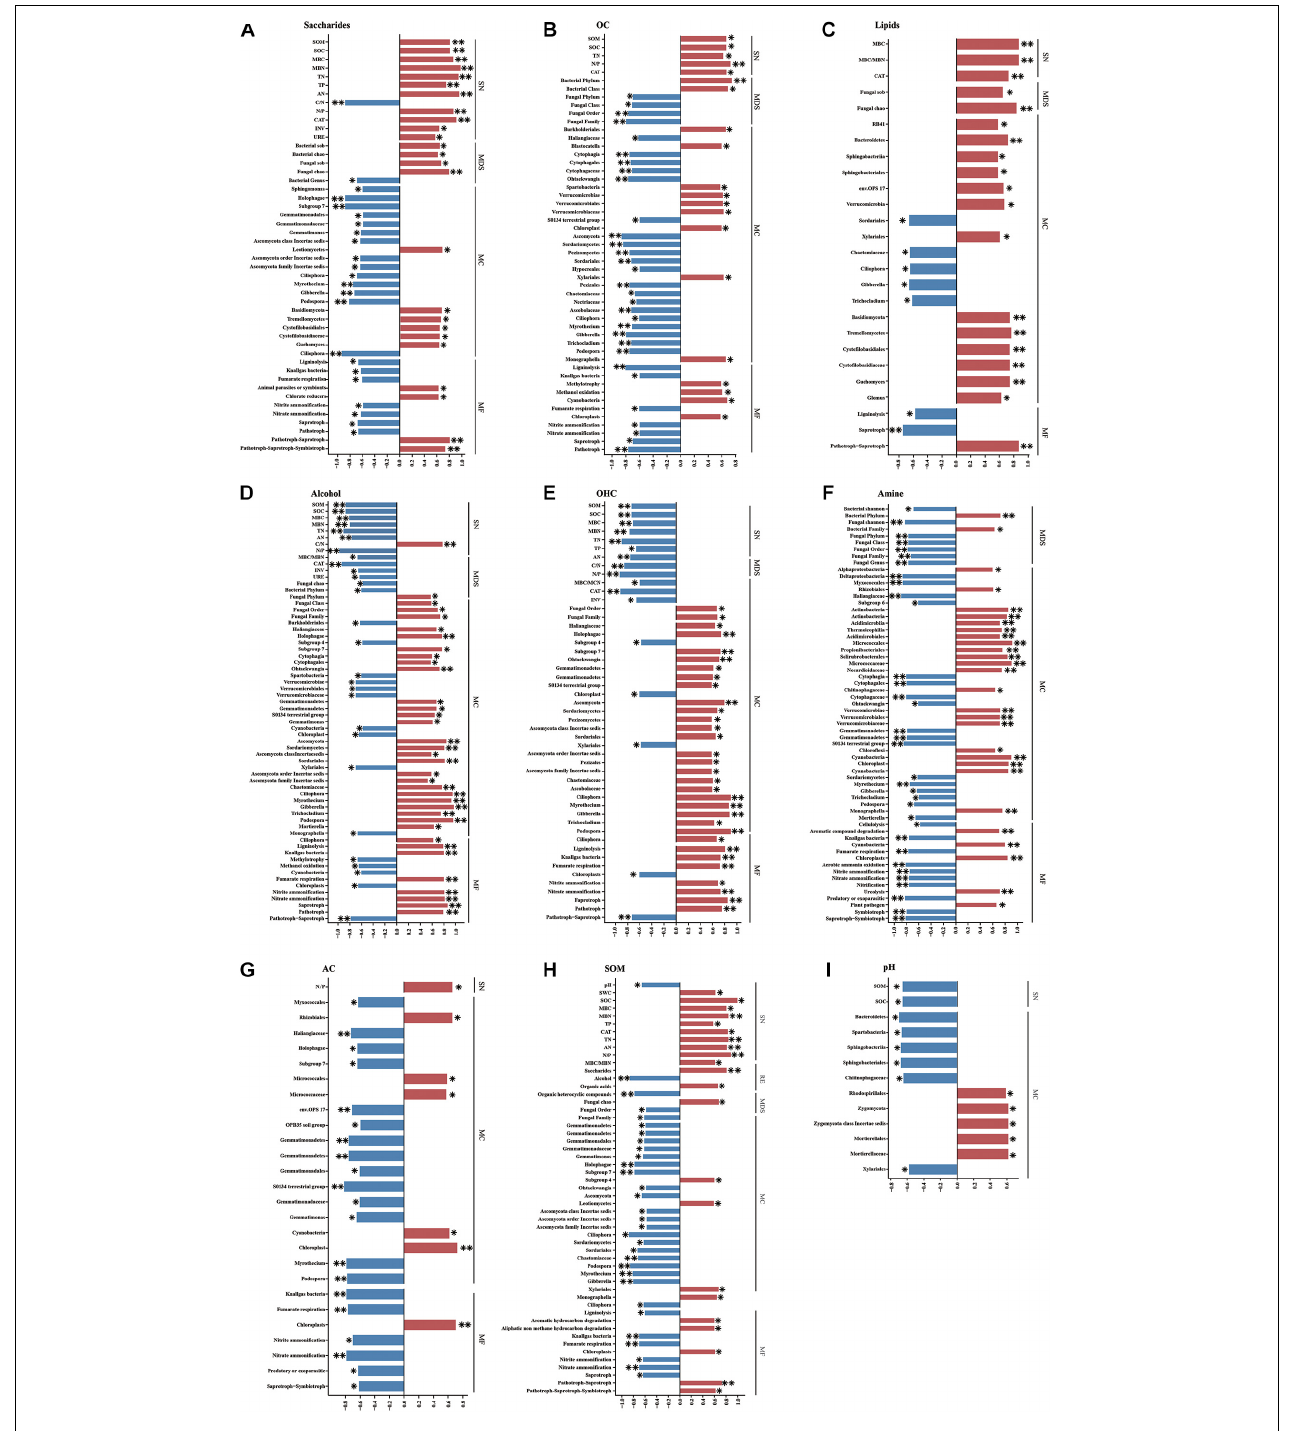
FIGURE 6 | Spearman’s correlation coefficients among soil basic physicochemical parameters, root exudates, microbial communities, and soil nutrients. (A) Saccharides and other variables, (B) OA and other variables, (C) lipids and other variables, (D) alcohol and other variables, (E) OHC and other variables, (F) amine and other variables, (G) AC and other variables, (H) SOM and other variables, (I) pH and other variables. SN, soil nutrients; RE, root exudates; MDS, the diversity and structure of the total microbial community; MC, the composition of the microbial community; MF, functional groups of the microbial community. * P < 0.05, ** P <